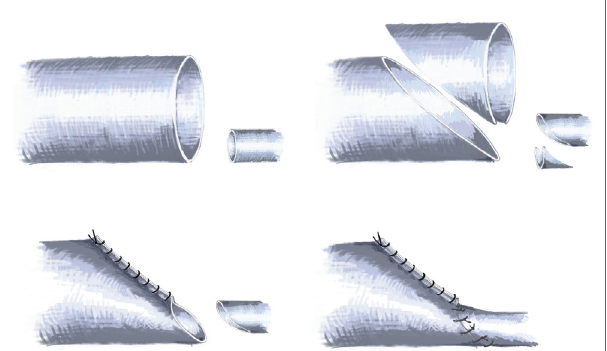
FiGURe 10 | Schematic drawing of the technique employed in cases of large caliber differences between recipient and flap vessels by chamfering the lumen